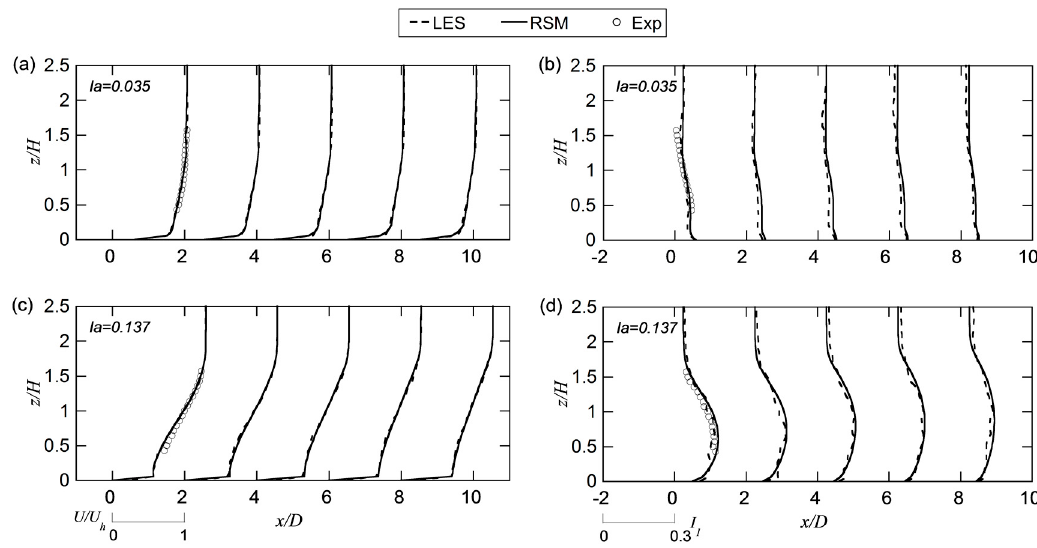
Figure 4. Vertical profiles in the simulated neutral atmospheric boundary layers without wind turbines: ( a , c ) for normalized mean velocity; ( b , d ) for turbulence intensity.